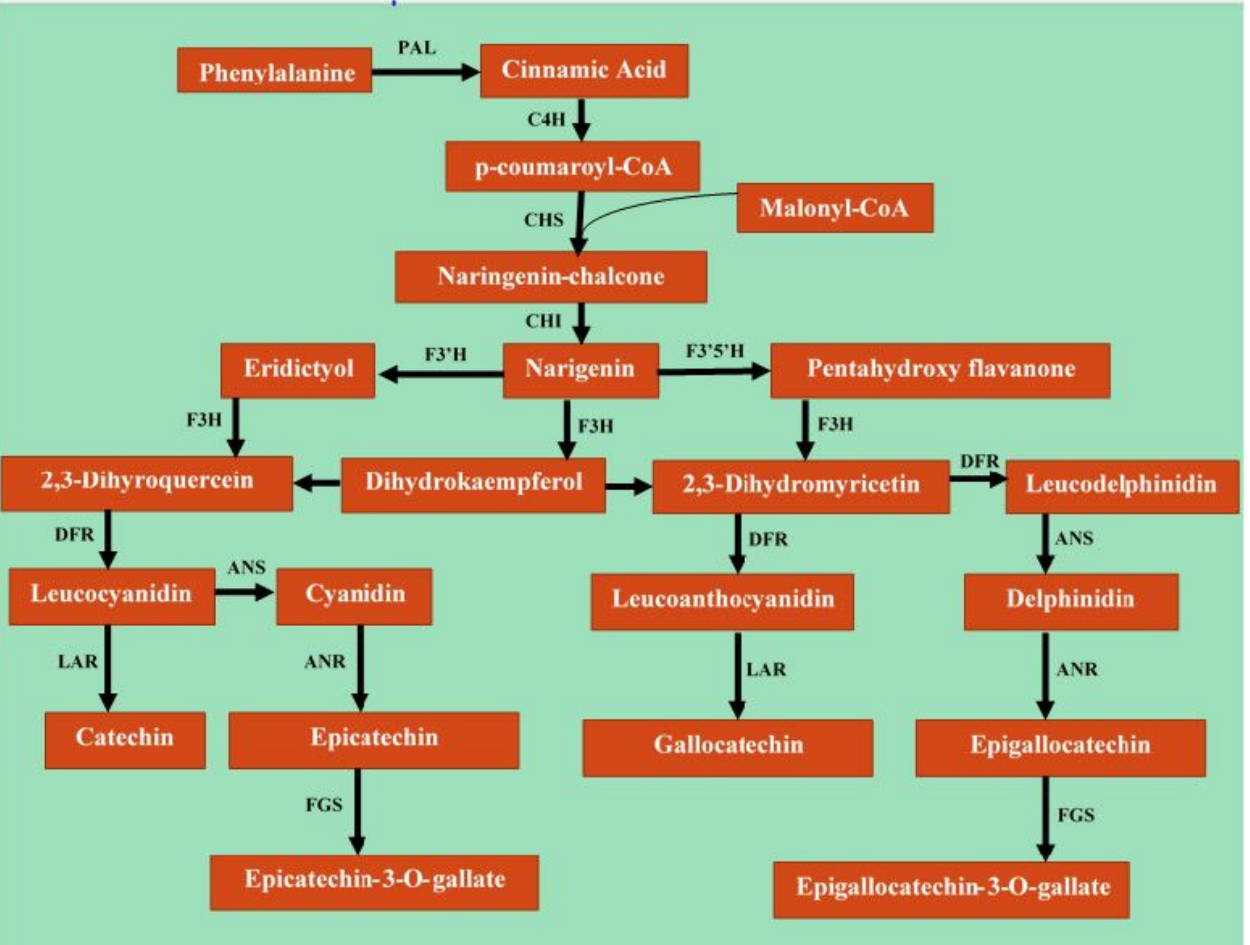
Figure 2. Biosynthesis of catechins in Camellia sinensis plant’s leaves via shikimic–cinnamic acid and acetic–malonic metabolic pathways. PAL, phenylalanine ammonia-lyase; C4H, cinnamate 4-hydroxylase; CHS, chalcone synthase; CHI, chalcone isomerase; F3H, flavanone 3-hydroxylase; F3 ′ H, flavonoid 3 ′ -hydroxylase; F3 ′ 5 ′ H, flavonoid 3 ′ ,5 ′ -hydroxylase; DFR, dihydroflavonol 4-Reductase; LAR, leucocyanidin reductase; ANR, anthocyanidin reductase; ANS, anthocyanidin synthase; FGS, flavan-3-ol gallate synthase.